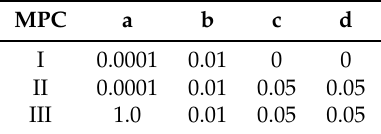
Table 2. Tuning parameters for the three different MPCs tested. MPC: Model Predictive